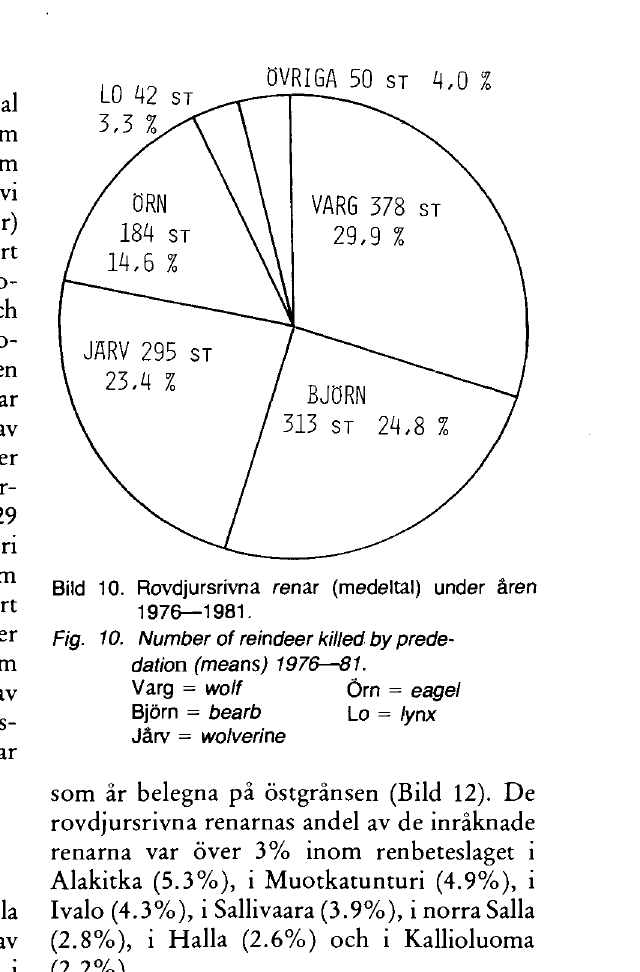
Fig. 10. Number of reindeer kil led by prede- dation (means) 1976—81. Varg = wolf Orn = eagel Bjorn = bearb Lo = lynx Jårv = wolverine som år belegna på ostgrånsen (Bild 12). De rovdjursrivna renarnas andel av de inråknade renarna var over 3% inom renbeteslaget